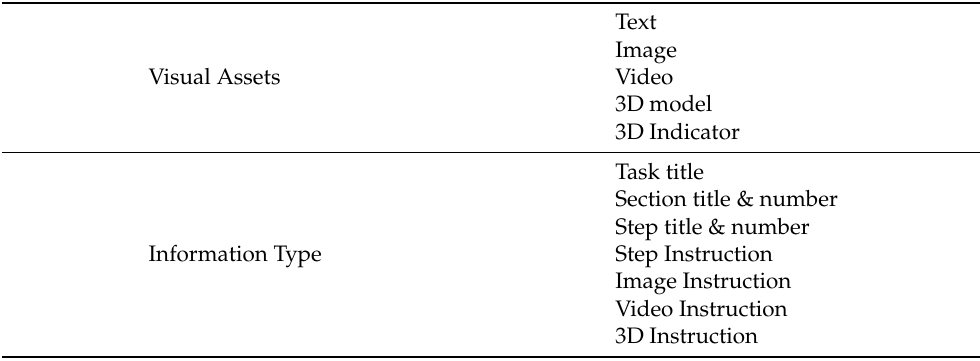
Table 1. Visual Assets